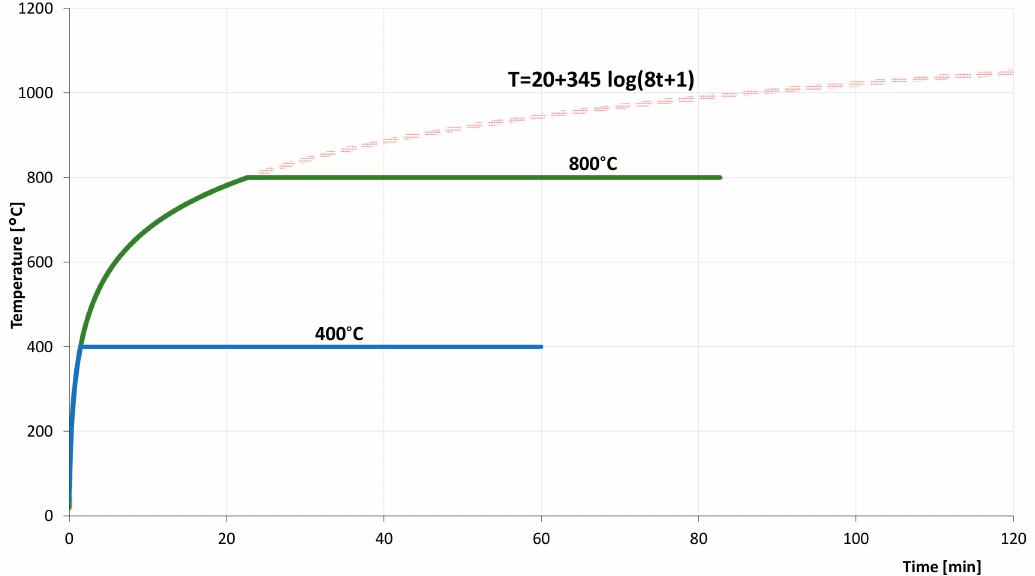
Figure 2. The diagram of temperature distribution while annealing concrete samples.